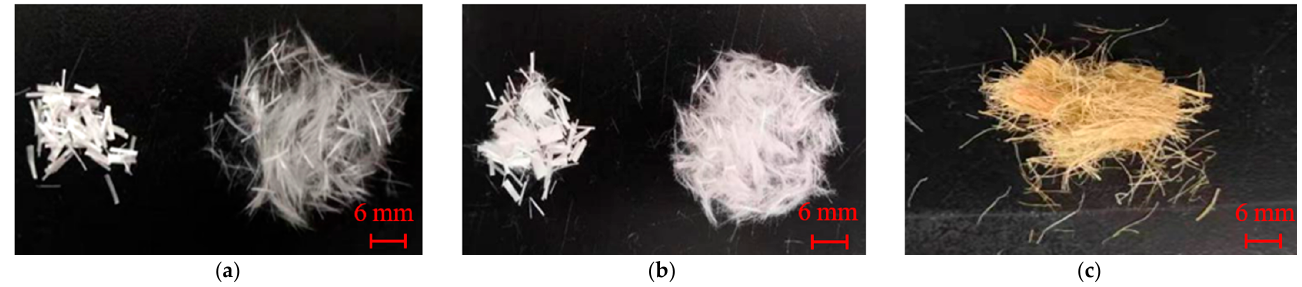
Figure 2. Morphology of the fibers: ( a ) Glass fiber; ( b ) Polyester fiber; ( c ) Hemp fiber.